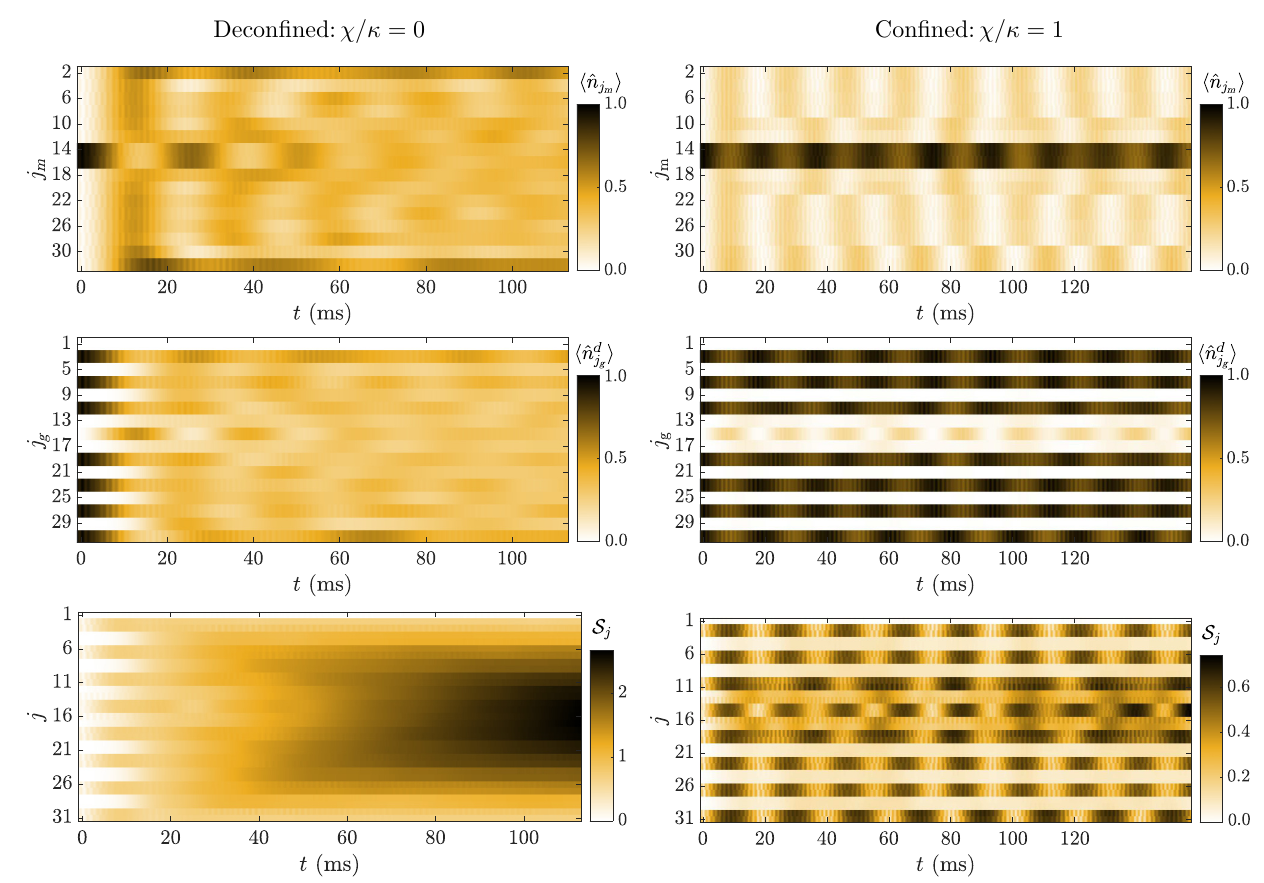
FIG. 10. Time evolution of the site-resolved matter occupation (top panels), which resides on even sites of the superlattice and represents the local chiral condensate, the site-resolved doublon occupation (middle panels) on odd sites of the superlattice, which represents the local electric flux, and the site-resolved bond-entanglement entropy (bottom panels) in the wake of a global quench at μ/κ = 0.35 starting in the electron-positron pair state, within either the deconfined regime ( χ/κ = 0, left-column panels) or its confined counterpart ( χ/κ = 1, right-column panels). In agreement with results in Sec. IV B 1, we find that a finite mass enhances the confinement for a given value of χ/κ . In the deconfined regime, a finite mass leads to quench dynamics that is markedly faster than the ballistic behavior seen in the corresponding case of a massless quench (see Fig. 9, left-column panels). However, at χ = κ , the confinement is much stronger for the quench at μ/κ = 0.35 than that at μ/κ =